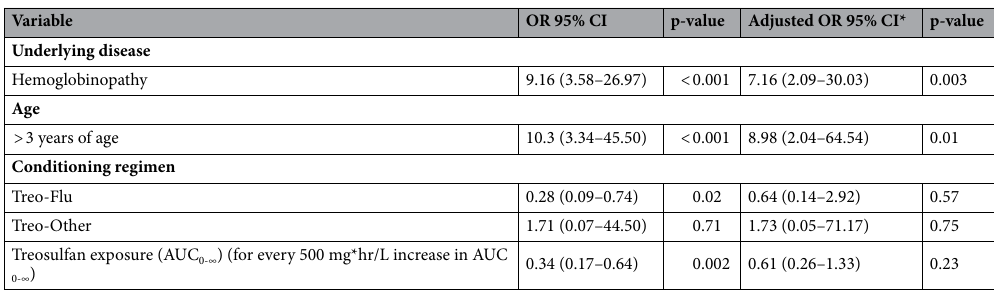
Table 3. Univariable and multivariable analysis of the treosulfan cohort. Treo treosulfan, Flu fludarabine, AUC Area under the concentration curve. Adjusted for underlying disease, age, conditioning regimen and treosulfan